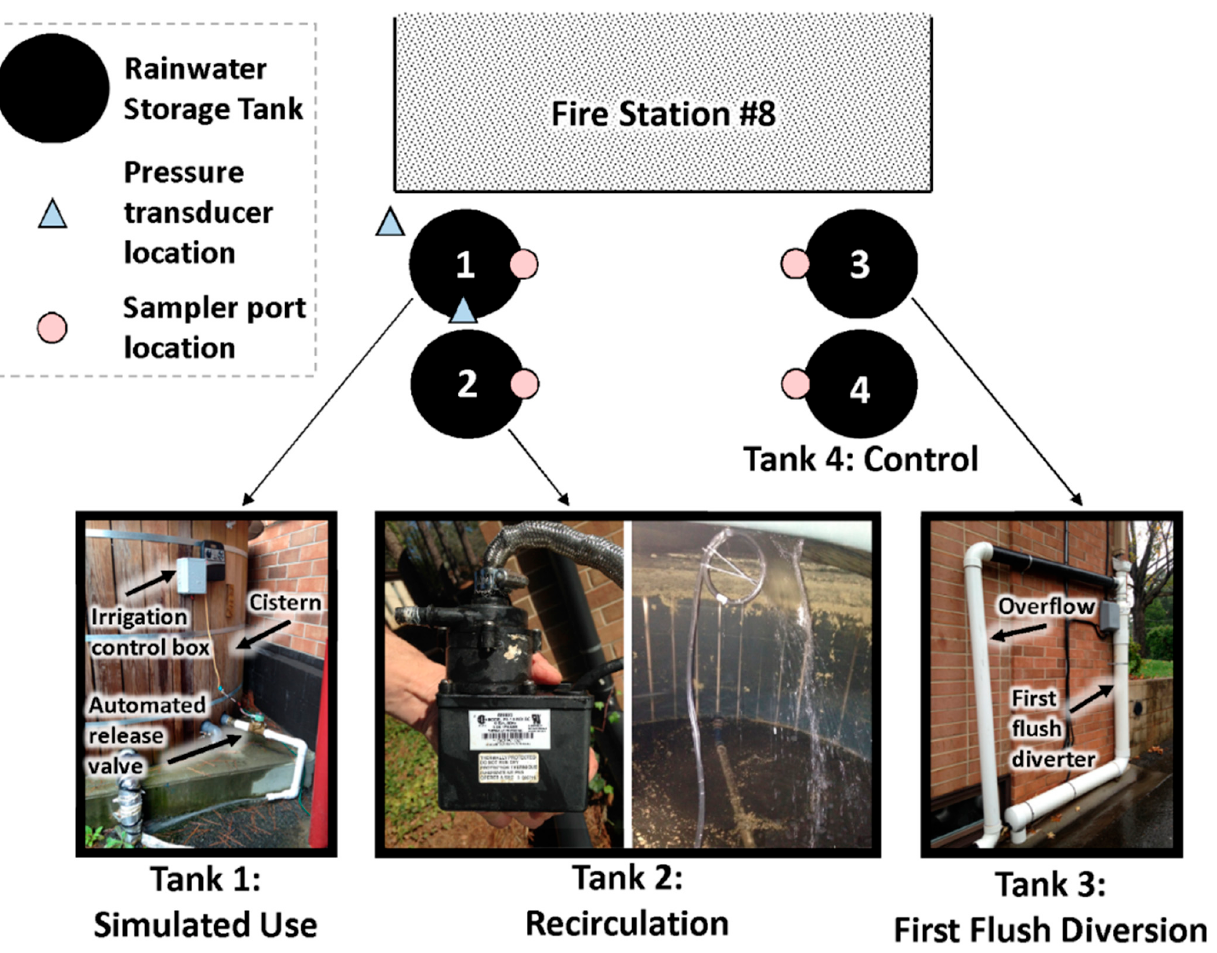
Figure 1. An aerial view of the RWH system layout at Fire Station #8, including the rainwater storage tanks, pressure transducer locations, and sampler port locations ( top ) and photos of the three treatment mechanisms implemented at each storage tank ( bottom ). Tank 4 served as the control and did not employ a treatment mechanism.